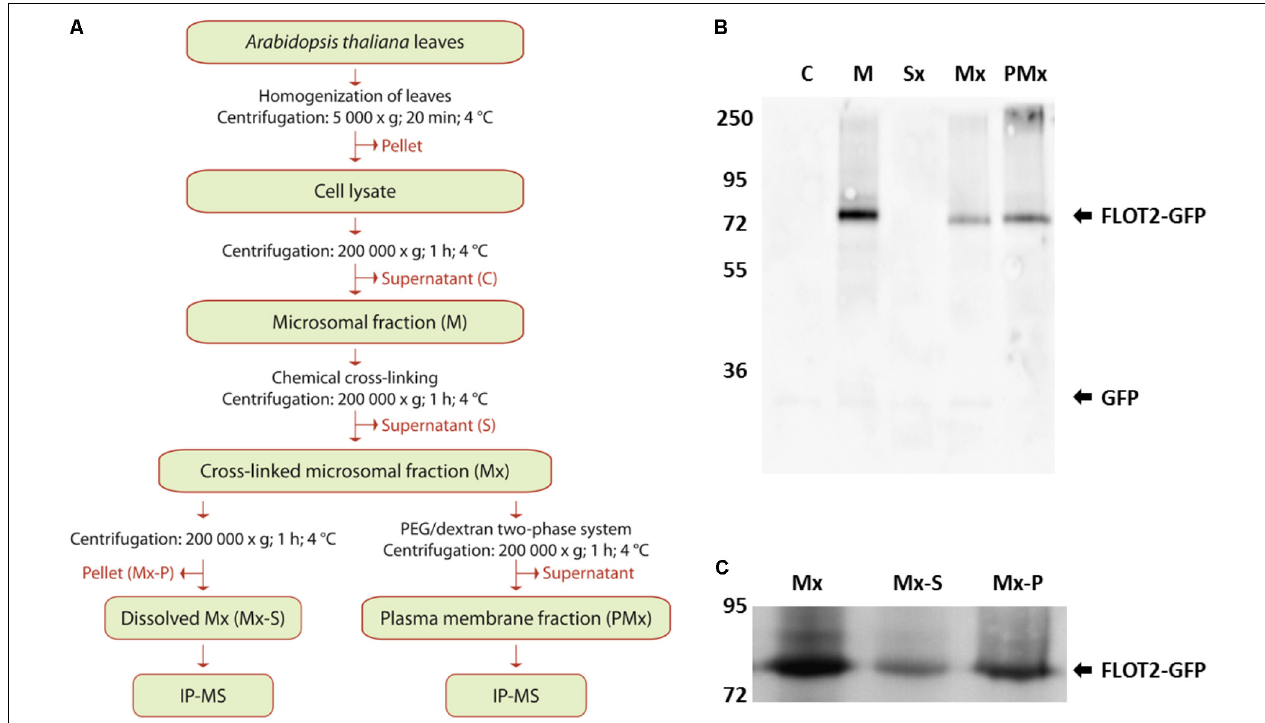
FIGURE 2 | Preparation and characterization of Flot2-GFP membrane fractions. (A) Flow chart of the preparation and analysis of membrane fractions; (B) Immunoblot analysis of Flot2-GFP content in cytosolic fraction (C), microsomal fraction (M), supernatant obtained after pelleting of cross-linked microsomal fraction (Sx), cross-linked microsomal fraction (Mx), plasma membrane fraction isolated from cross-linked microsomal fraction (PMx), 0.5 µ g of total proteins were loaded into all lines; (C) Immunoblot analysis of Flot2-GFP content in whole cross-linked microsomal fraction (Mx), fraction dissolved by 0.5% (w/v) sodium deoxycholate (Mx-S) and fraction undissolved by 0.5% (w/v) sodium deoxycholate (Mx-P), 10 µ g of total proteins were loaded into all